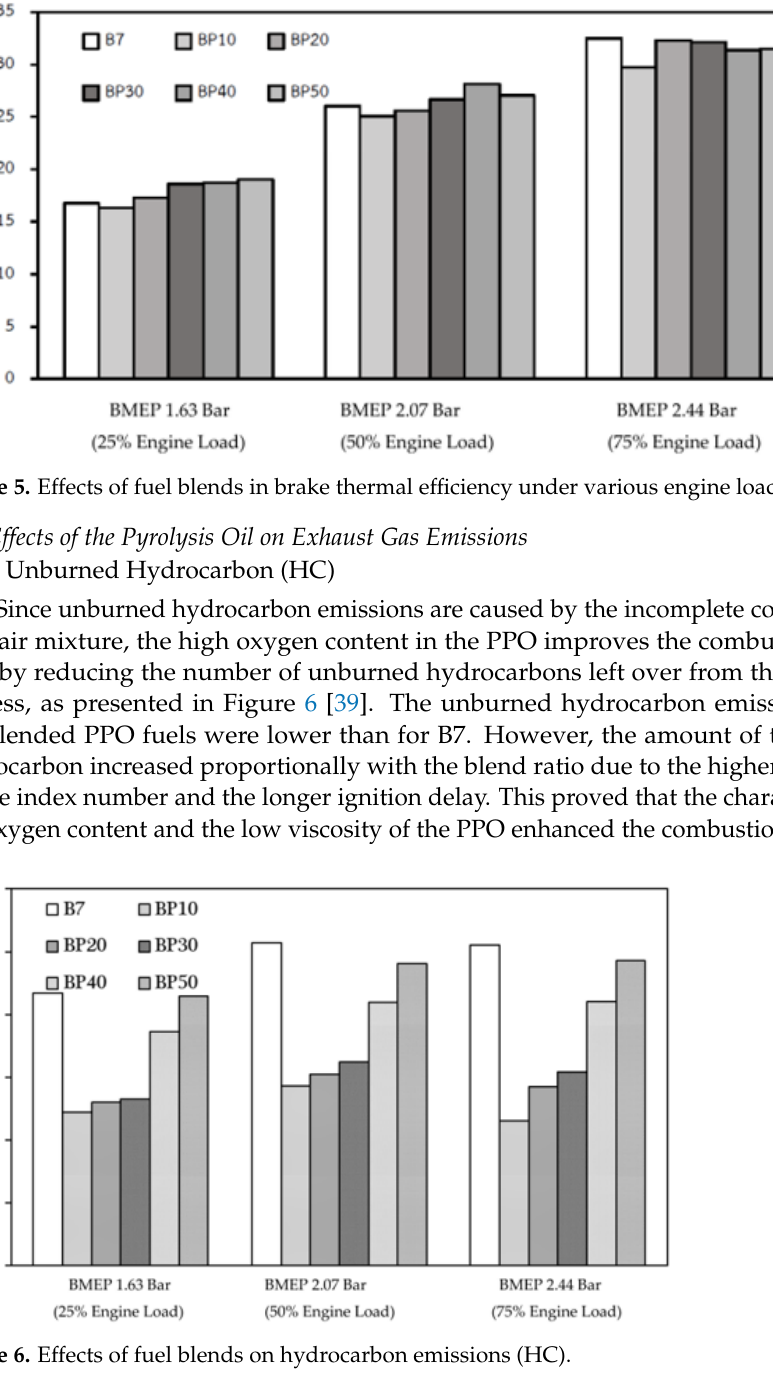
Figure 4. Effects of fuel blends in brake specific fuel consumption under various engine loads.